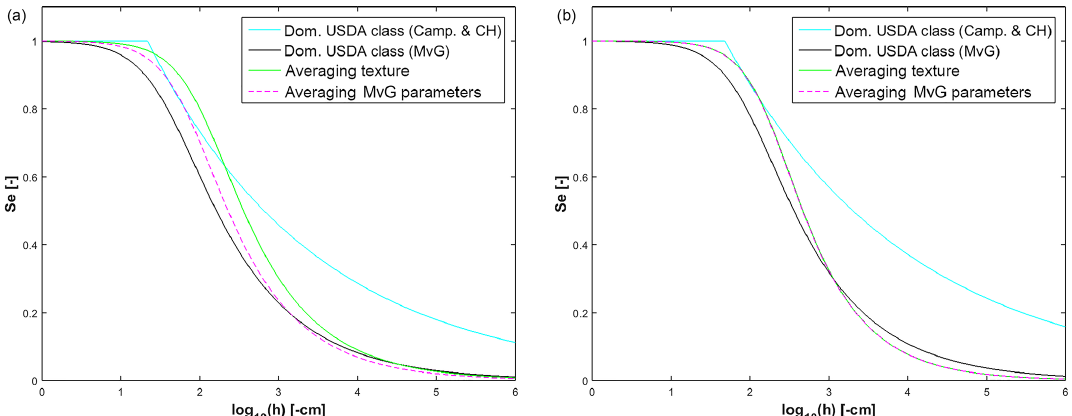
Figure 7. PF curve after applying typical scaling or aggregation methods: by dominant USDA soil class and Clapp and Hornberger param- eters for the Brooks and Corey equation, by dominant USDA soil class and MvG equation, by averaging soil texture parameters and then applying ROSETTA PTFs, and by averaging MvG soil hydraulic parameters directly, for Lower Saxony (left) and North Rhine-Westphalia (right).